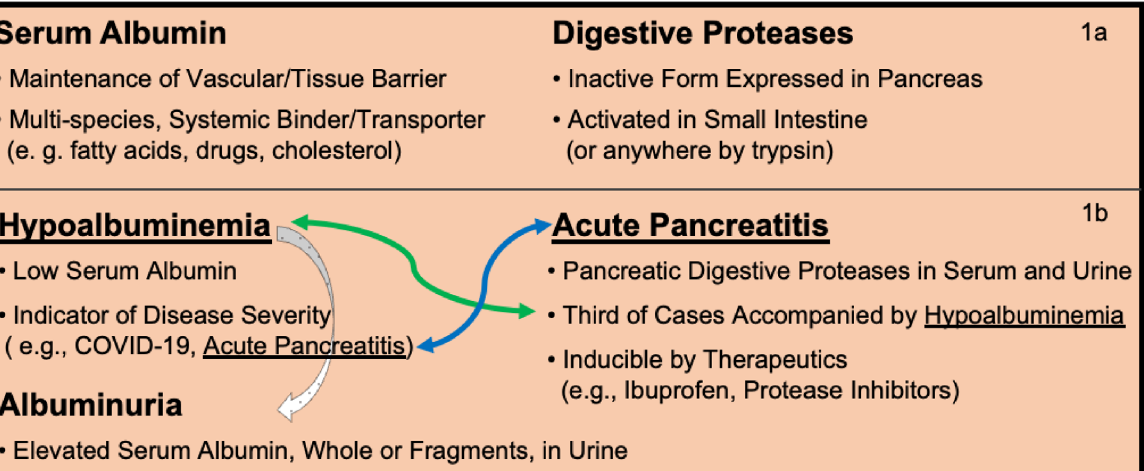
Figure 1. The molecular entities of primary interest are listed and described in 1a: serum albumin and the digestion proteases formed in the pancreas. The activity of these proteins are intimately connected to three clinical states as noted in 1b. In hypoalbuminemia serum albumin concentration drops while it increases in the urine. Hypoalbuminemia is a severity indicator of multiple disease states including acute pancreatitis manifest by in-pancreatic activation of digestive proteases. A third of acute pancreatitis victims also manifest hypoalbuminemia. Acute pancreatitis can be induced by many over-the-counter and prescription